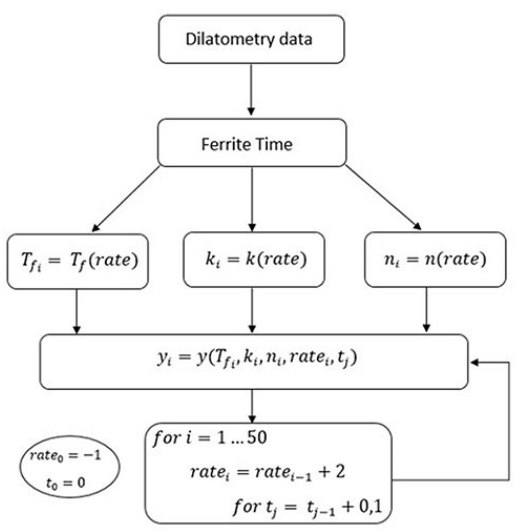
Figure 9. Schematic representation of the used algorithm.